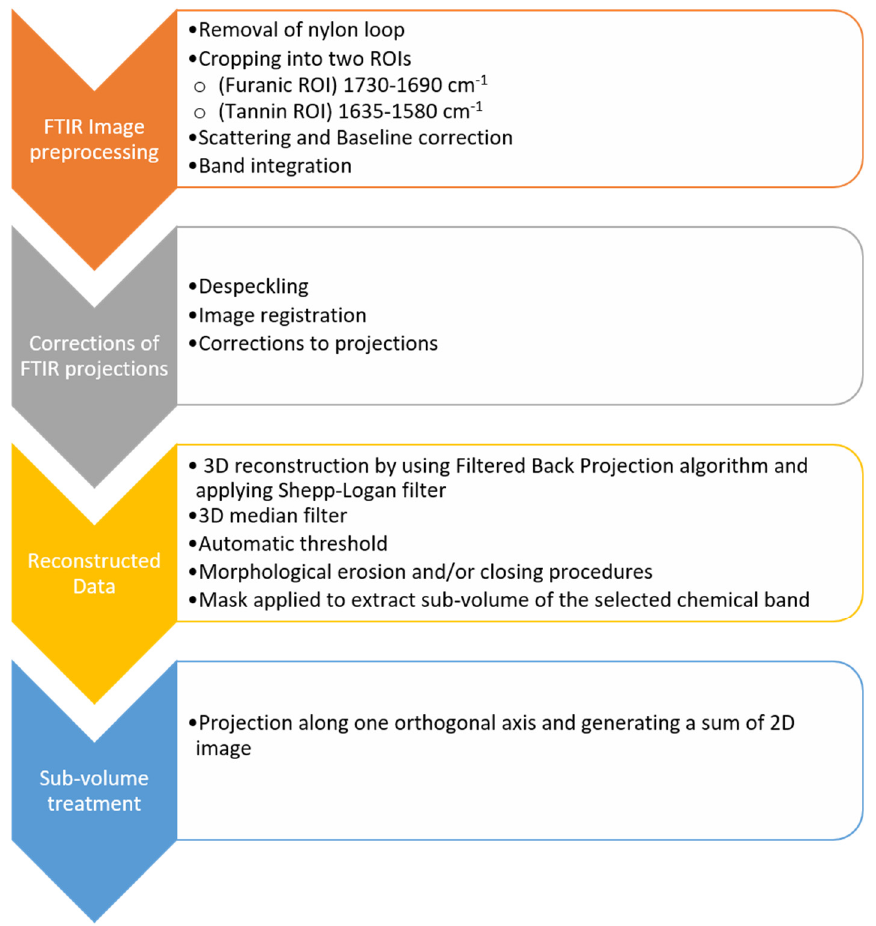
Figure B1. 3D FTIR μ -CT data processing workflow. Figure A2. 3D FTIR µ -CT data processing workflow data processing